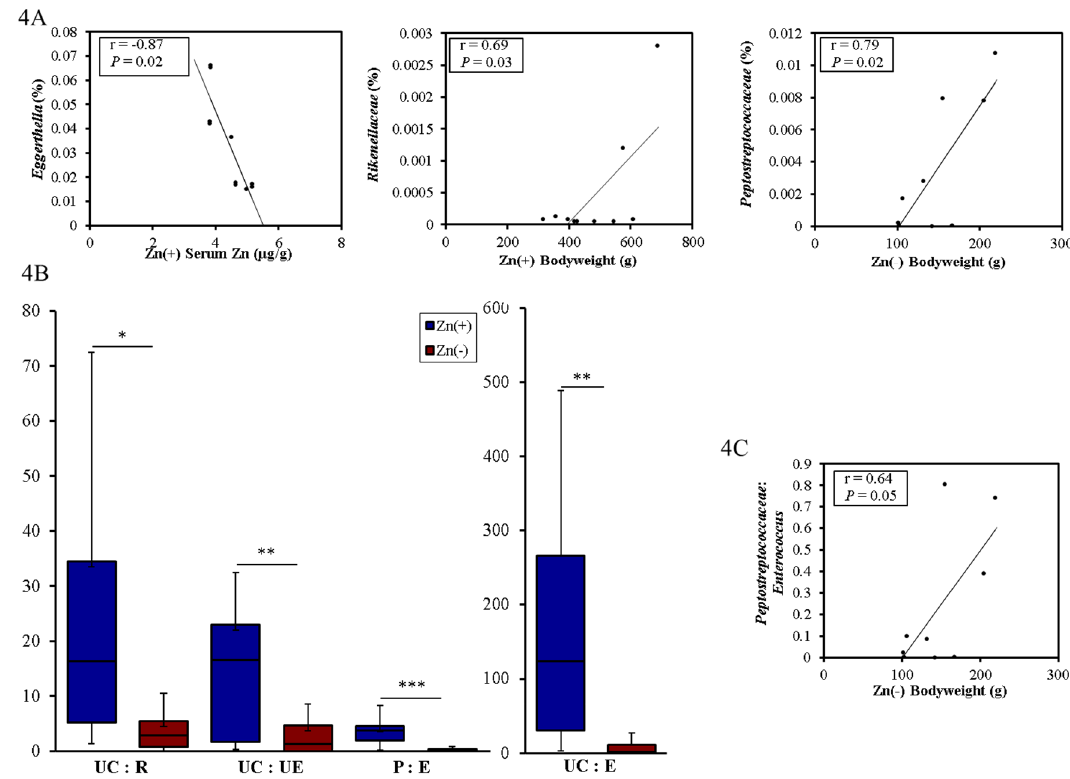
Figure 4. Genera–level correlations and ratios of cecal bacteria between the Zn(+) and Zn( − ) groups. ( A ) Relative abundance of certain bacterial genera that significantly correlate with either treatment ‐ specific serum Zn or bodyweight; ( B ) Ratios of bacterial genera that are significantly higher in the Zn(+) group (* p < 0.05, ** p < 0.01, *** p < 0.001, ANOVA); ( C ) Peptostreptococcaceae:Enterococcus ratio positively correlates with bodyweight in the Zn deficiency group.